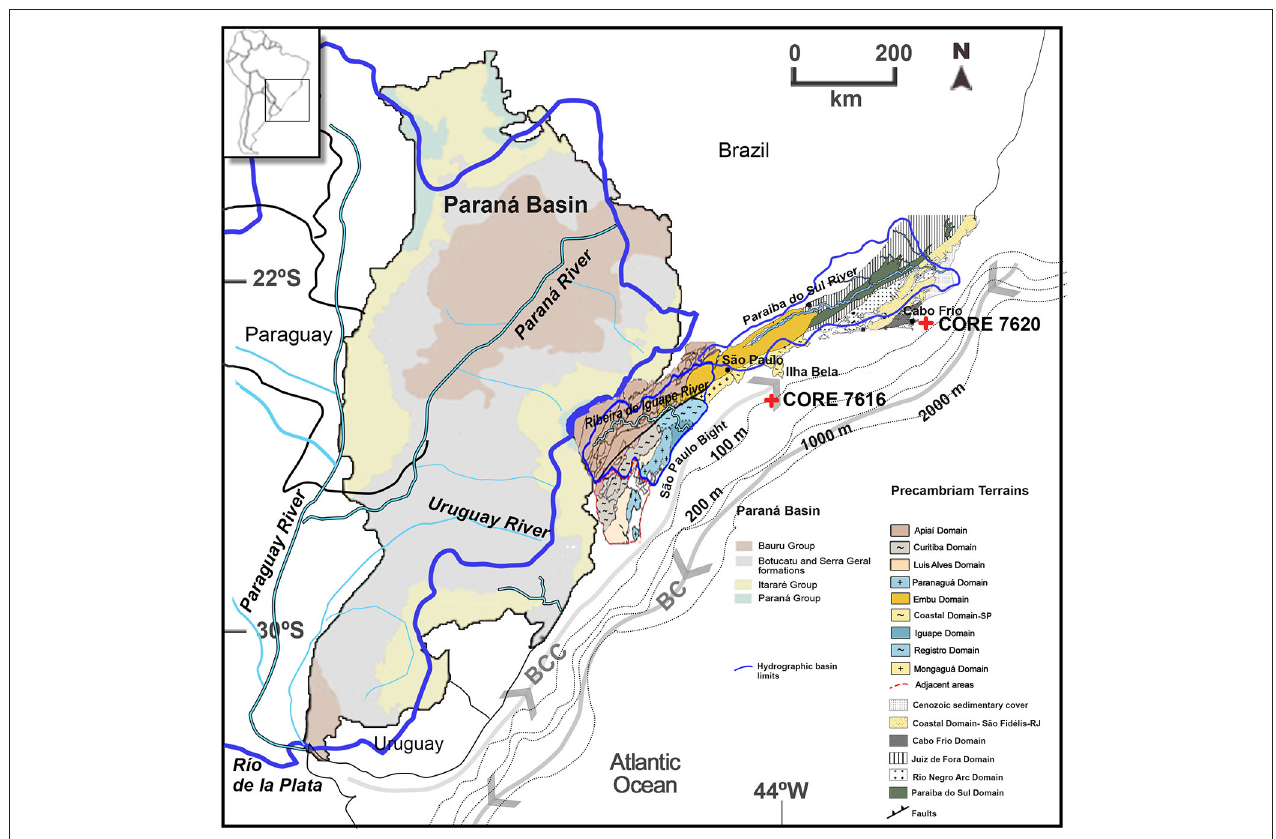
FIGURE 1 | Regional geotectonic context of the area investigated as possible sources for cores 7620 and 7616 (red marks), showing Paraíba do Sul, Río de la Plata, and Ribeira de Iguape River basin limits (blue lines). Gray lines show major surface current directions in the study area: BC (Brazil Current) and BCC (Brazilian Coastal Current). Compiled from Siga (1995), Milani et al. (1996), Campanha and Sadowski (1999), Carlos Pedrosa-Soares et al. (1998), Marques et al. (1999), Milani and Thomaz Filho (2000), Dias Neto (2001), Heilbron et al. (2004), Passarelli et al. (2004), and Valladares et al.